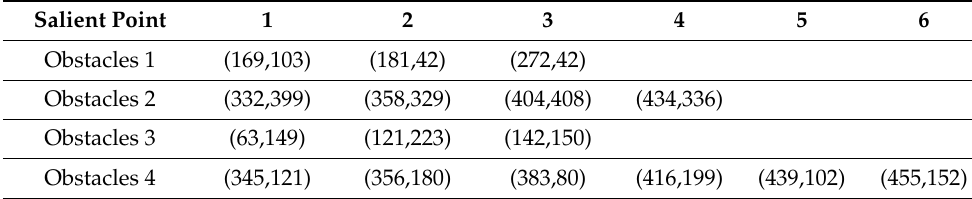
Table 3. Coordinates of salient points under the plane with sparse obstacles